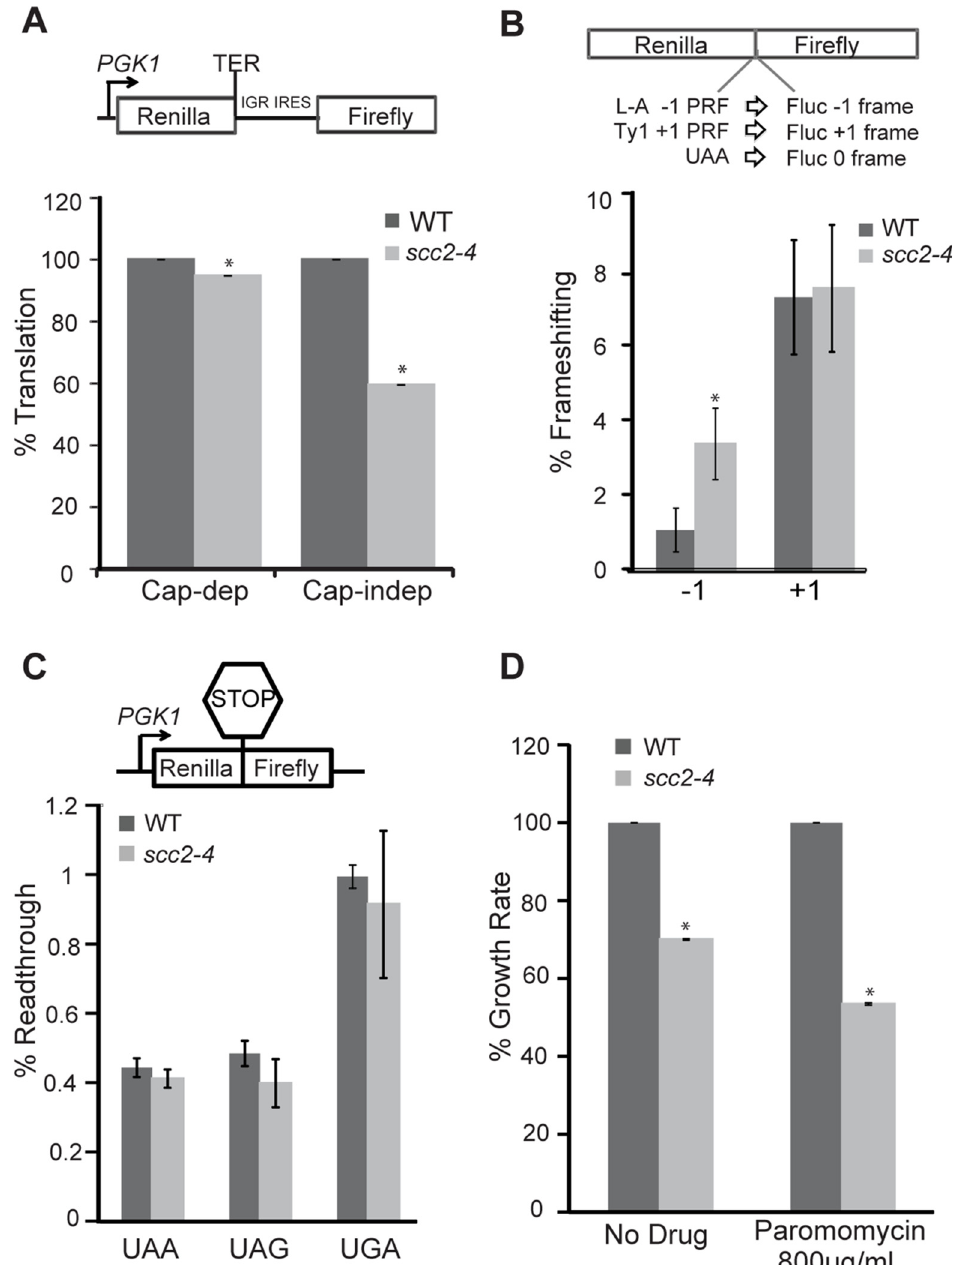
Fig 8. Translational fidelity is reduced in the scc2-4 mutant. Dual luciferase reporters were used to measure translation. (A, top) Schematic diagram of CrPV IGR IRES containing reporter. Renilla luciferase is translated by a cap-dependent mechanism, and firefly luciferase synthesis requires cap-independent initiation mediated by the IRES. While cap-dependent translation is mildly impaired (p = 0.01), IRES- dependent translation is more strongly inhibited in the scc2-4 mutant (p = 0.001). (B, top) A dual luciferase reporter was used to monitor -1 frameshifting mediated by sequence derived from the yeast L-A virus, and +1 frameshifting promoted by the yeast Ty1 sequence. In-frame renilla luciferase translation serves as a normalization control, and efficiencies were determined as previously described (Landry et al., 2009) The mutant shows an increase in -1 frameshifting. (C). Readthrough efficiency for three different stop codons (UAA, UAG, UGA) was measured for the WT and scc2-4 strains. The translation of renilla luciferase serves as a normalization control. (D) The maximal growth rates of the WT and scc2-4 mutant strains were compared, with the WT growth rate set to 100%. Strains were grown in YPD or YPD with paromomycin.